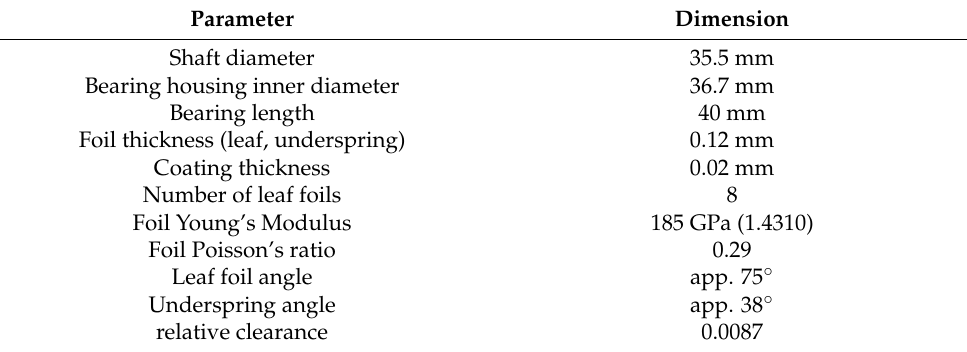
Table 1. Parameter leaf-type